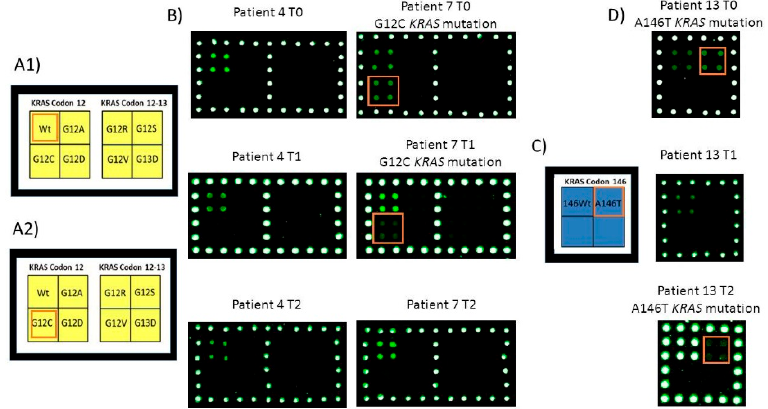
Figure 4. Analysis of ctDNA extracted from plasma of patient 4, 7 and 13 at T0, T1 and T2 time points. ( A1 , A2 ) Spotting schema of the portion of the barcode probe array reported in Figure 2A corresponding to the barcode probes for KRAS codon 12 and 13. ( B ) Cy3 fluorescence images of the analysis of ctDNA extracted from plasma of patient 4 and 7 at T0, T1 and T2 time points. The barcode probes corresponding to KRAS G12C in patient 7 are highlighted; the patient 4 is KRAS wild-type. ( C ) Spotting schema of the portion of the barcode probe array reported in Figure 2A corresponding to the barcode probes for KRAS codon 146. ( D ) Cy3 fluorescence images of the analysis of ctDNA extracted from plasma of patient 13 at T0, T1 and T2 time points. The barcode probes corresponding to KRAS A146T in patient 13 are highlighted.